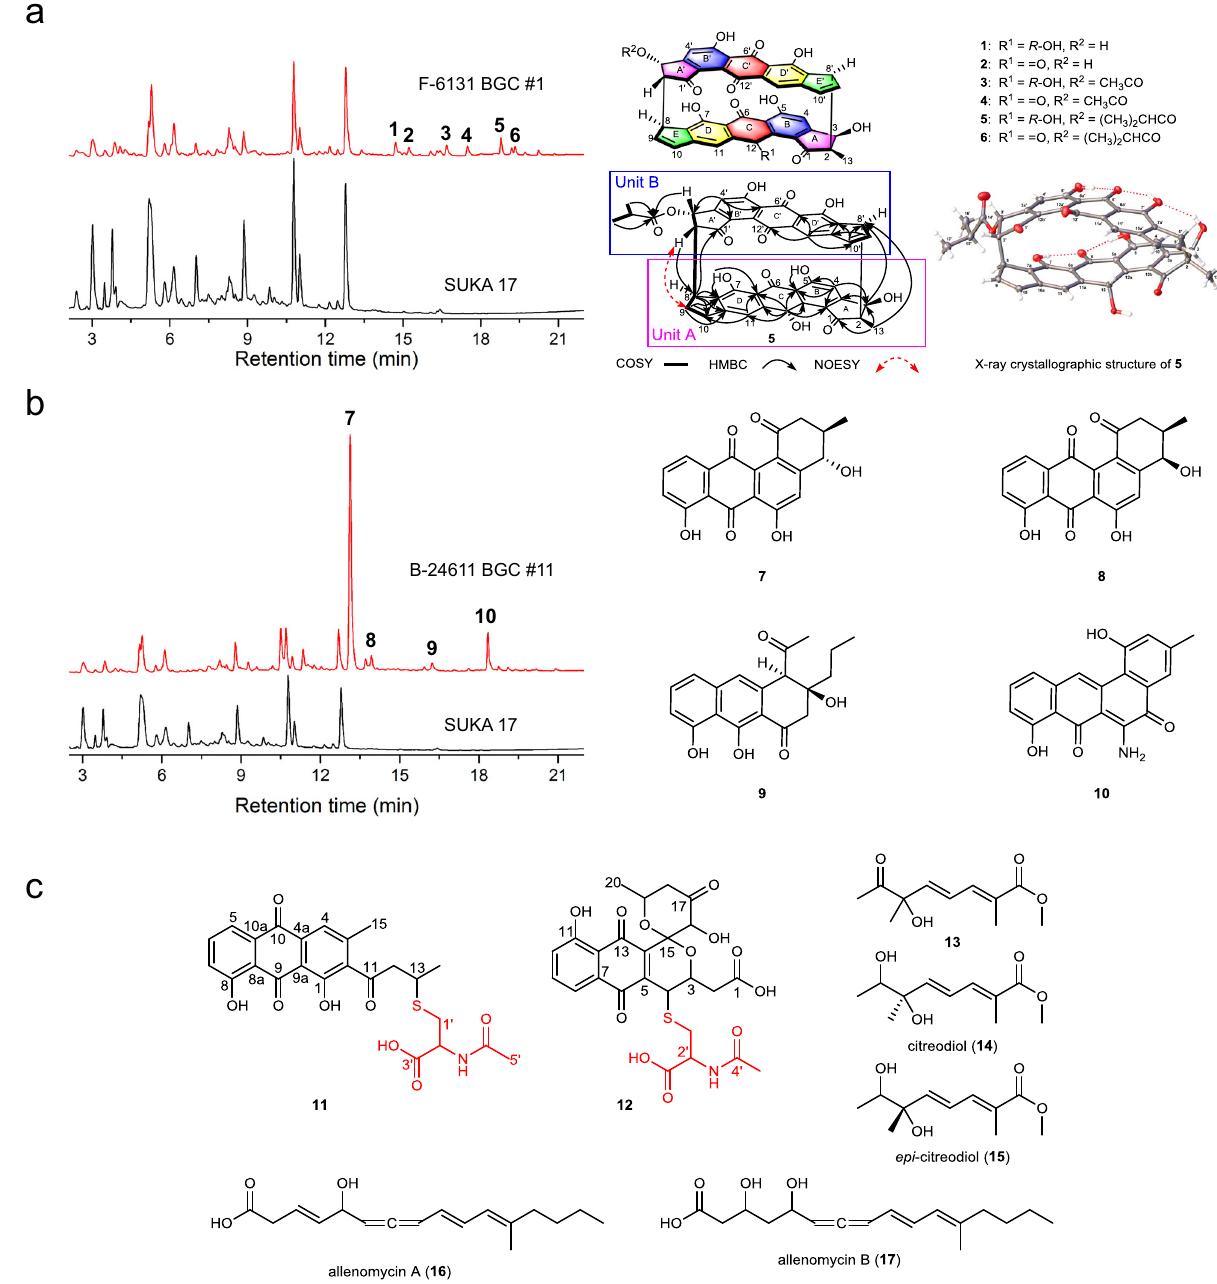
Fig. 3 Metabolic pro fi le and chemical structures of the characterized compounds from heterologous expression of fi ve of the seven positive uncharacterized BGCs. a HPLC analysis of the crude extract from heterologous expression of BGC #1 from Streptomyces sp. NRRL F-6131 in S. avermitilis SUKA17 and the chemical structures for the 6 heterodimers ( 1 – 6 ). b HPLC analysis of the crude extract from heterologous expression of BGC #11 from Streptomyces alni NRRL B-24611 in S. avermitilis SUKA17 and the chemical structure for the 4 new angucyclines and derivatives ( 7 – 10 ). c Chemical structures of the rest of characterized compounds including two new anthraquinone or naphthoquinone derivatives ( 11 and 12 ) containing an acetylcysteine moiety identi fi ed from Streptomyces cyaneofuscatus NRRL B-2570 BGC #2, two molecules allenomycin A and allenomycin B ( 16 and 17 ) identi fi ed from Streptomyces griseofuscus NRRL B-5429 BGC #25, two known citreodiols ( 14 and 15 ) and a new derivative ( 13 ) identi fi ed from S. griseofuscus NRRL B-5429 BGC